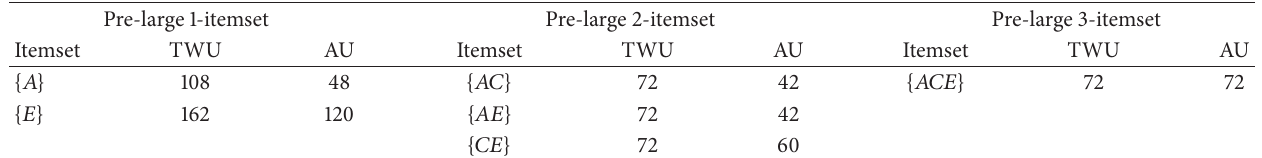
Table 10: The pre-large transaction-weighted utilization itemsets.